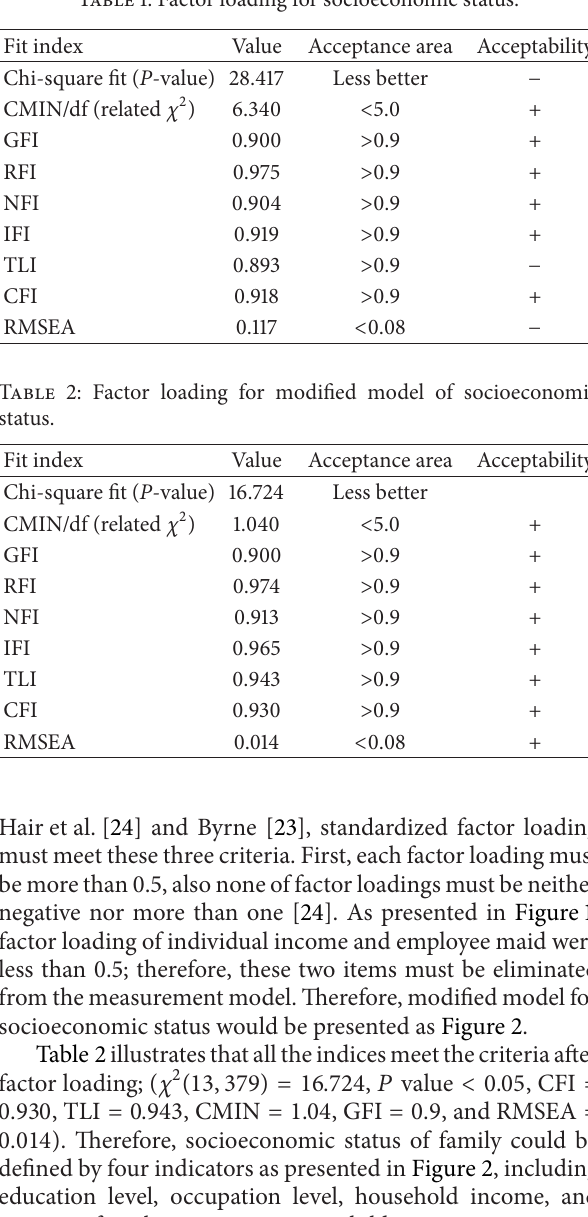
Figure 1: Measurement model for socioeconomic status before factor loading. Table 1: Factor loading for socioeconomic status.